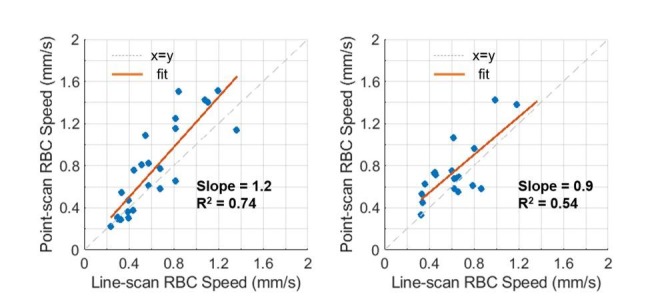
Correlation between the line-scan and point-scan RBC-speed values in the capillaries having the diameter of 2-3 µm (left panel) and 3-5 µm (right panel).